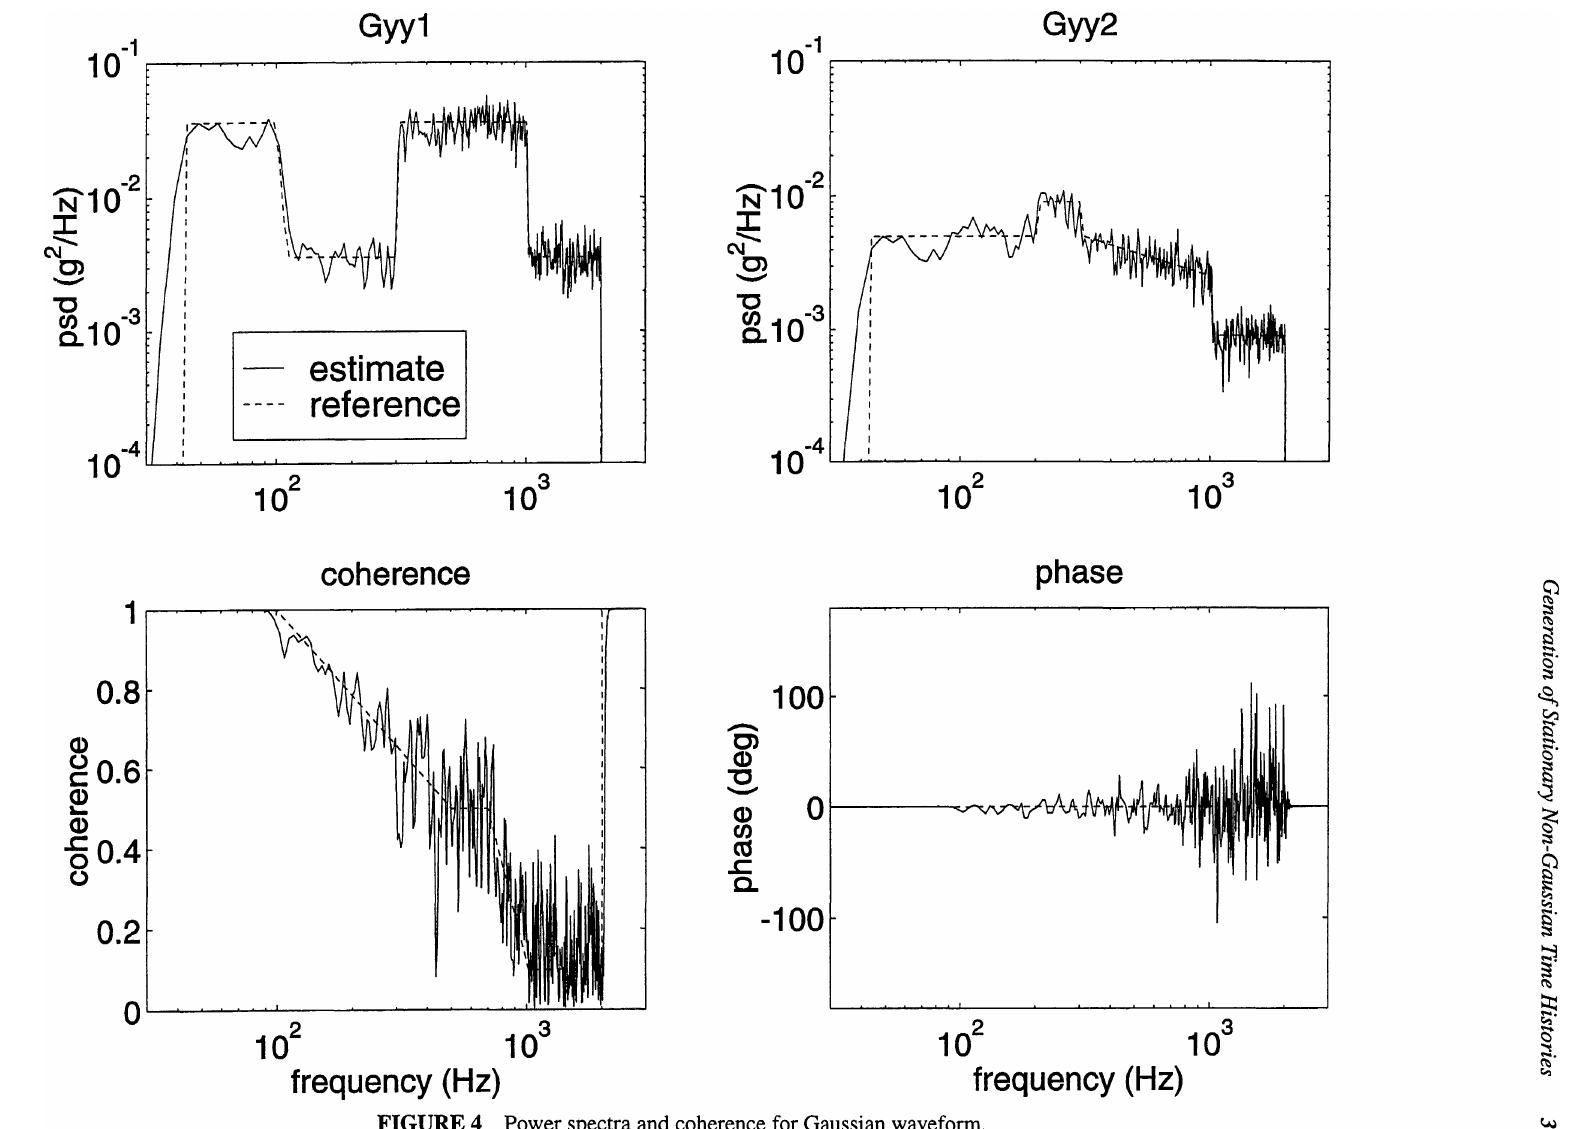
FIGURE 4 Power spectra and coherence for Gaussian